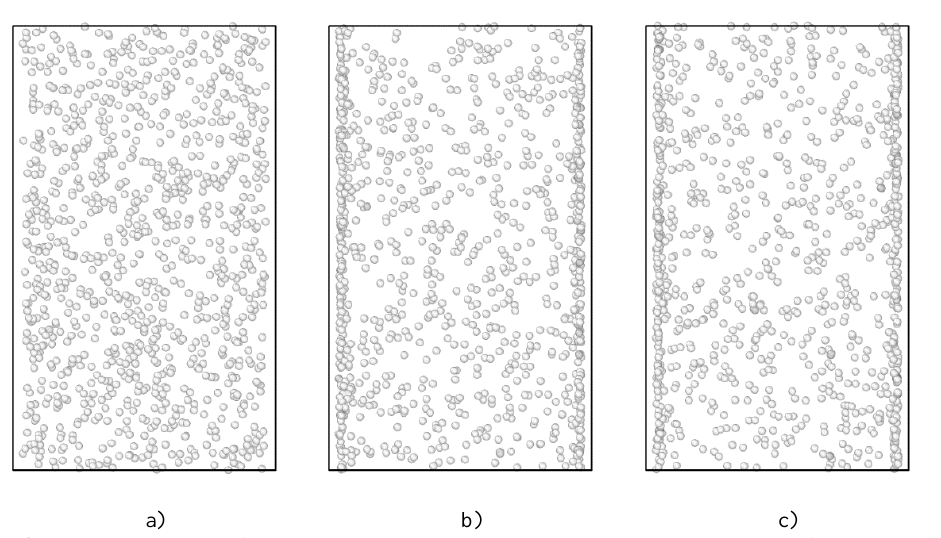
Fig. 1. The distribution of PCN molecules in a slit-shaped silicon nanopore with a size of 10 nm at different times after the start of relaxation: a) 0.2 ns, b) 10 ns, c) 25 ns. The average density of PCN in